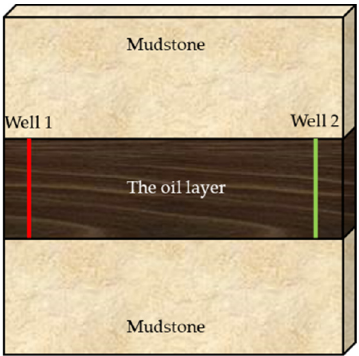
Figure 1. Schematic of the 2D experimental model.